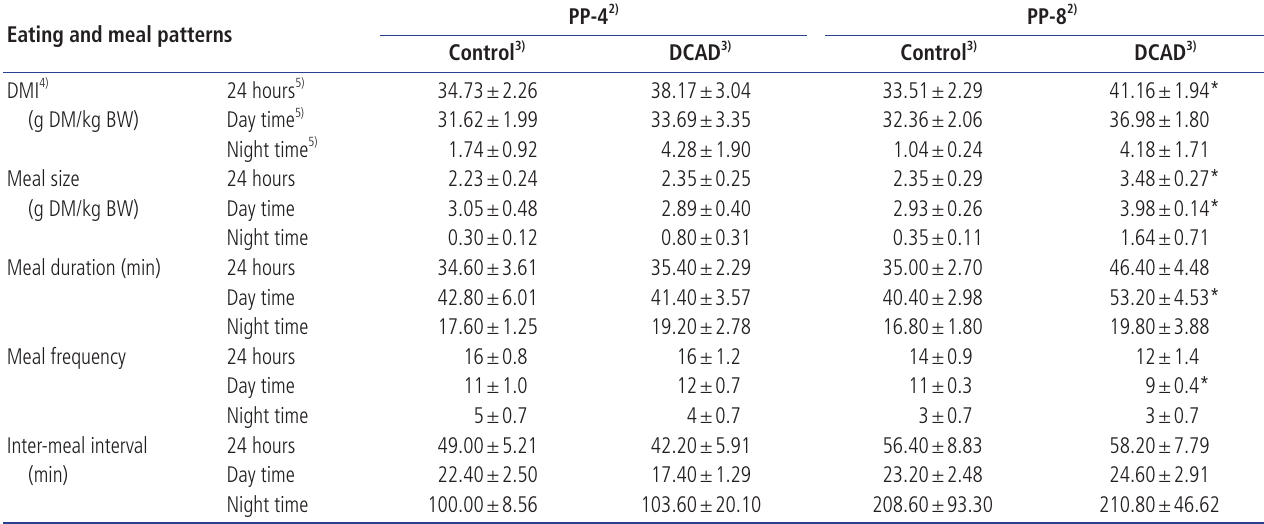
Table 3. Effect of high DCAD on eating and meal patterns at the 4th and 8th weeks postpartum 1)